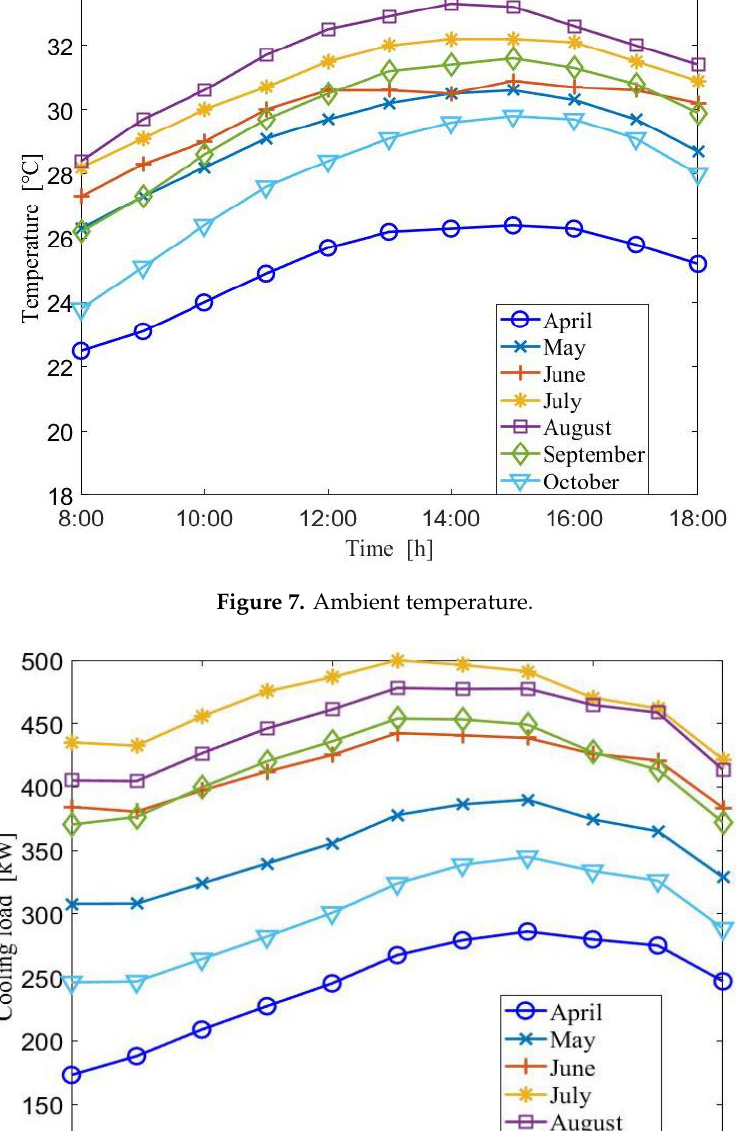
Figure 6. Solar radiation.